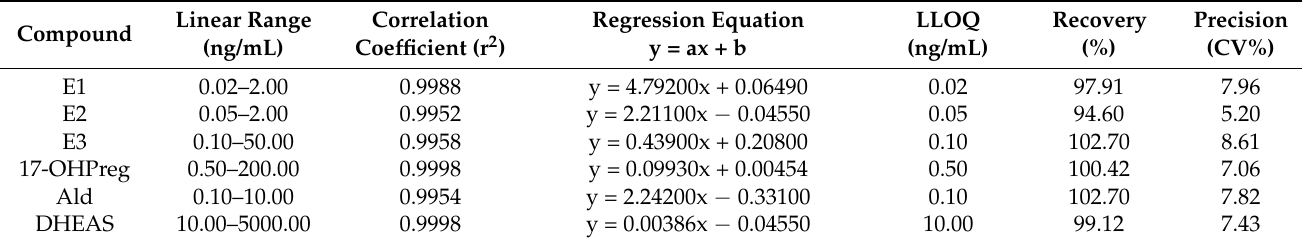
Table 3. Linear range, correlation coefficient and LLOQ of different